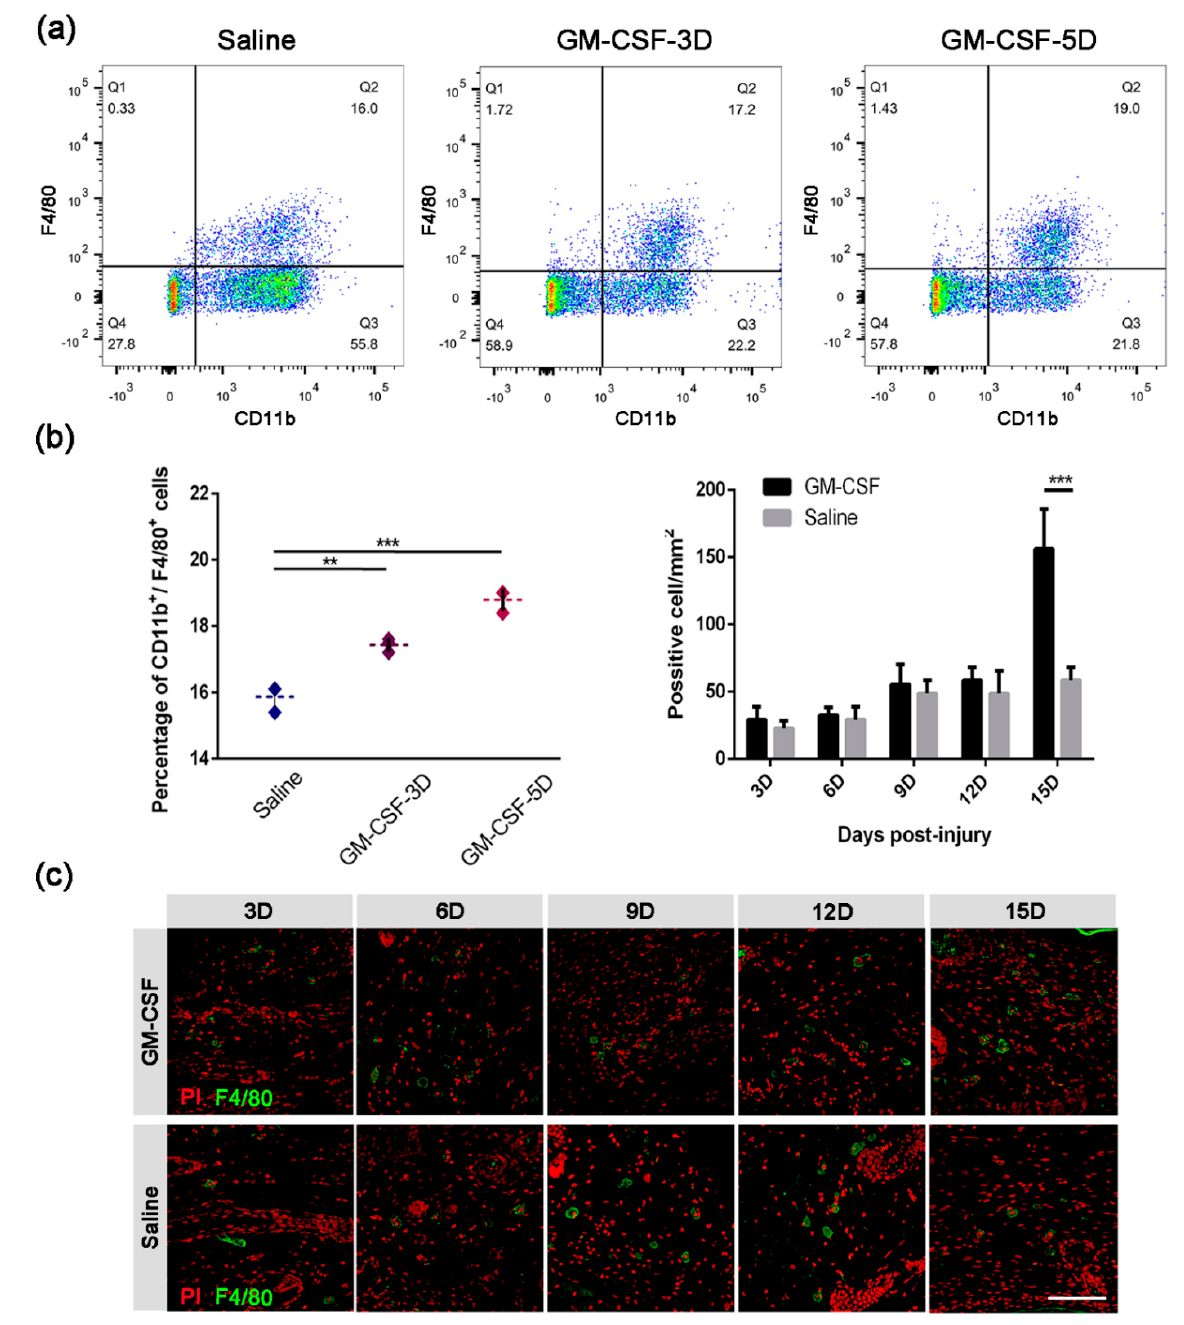
Figure 5. Quantification of macrophages in peripheral blood and wound tissue after treatment with GM-CSF. ( a ) Flow cytometry analysis of macrophages in peripheral blood based on surface marker CD11b and F4/80. The statistics of the two positive cells are presented as mean ± SD in subfigure ( b ), left ( n ≥ 3. ** p < 0.01, *** p < 0.001). ( c ) IF staining of tissue sample sections from either GM-CSF- or saline-injected mice, using anti-F4/80 antibody (scale bar: 100 µ m). The statistics of F4/80 positive cells in the high-power field are presented as mean ± SD in subfigure ( b ), right ( n ≥ 3. ** p < 0.01, *** p <